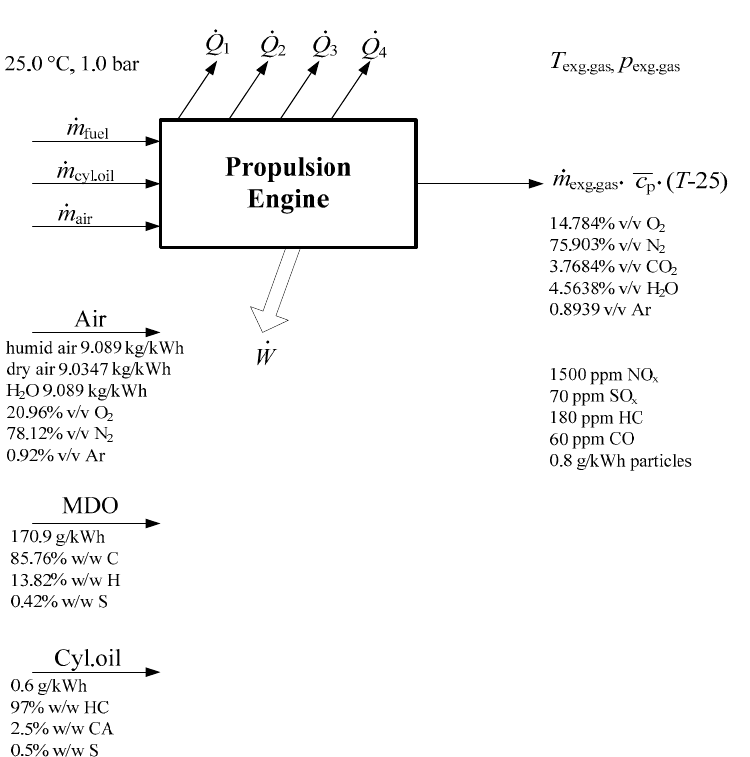
Table 8. The exhaust gas composition at 100% SMCR, ISO conditions.